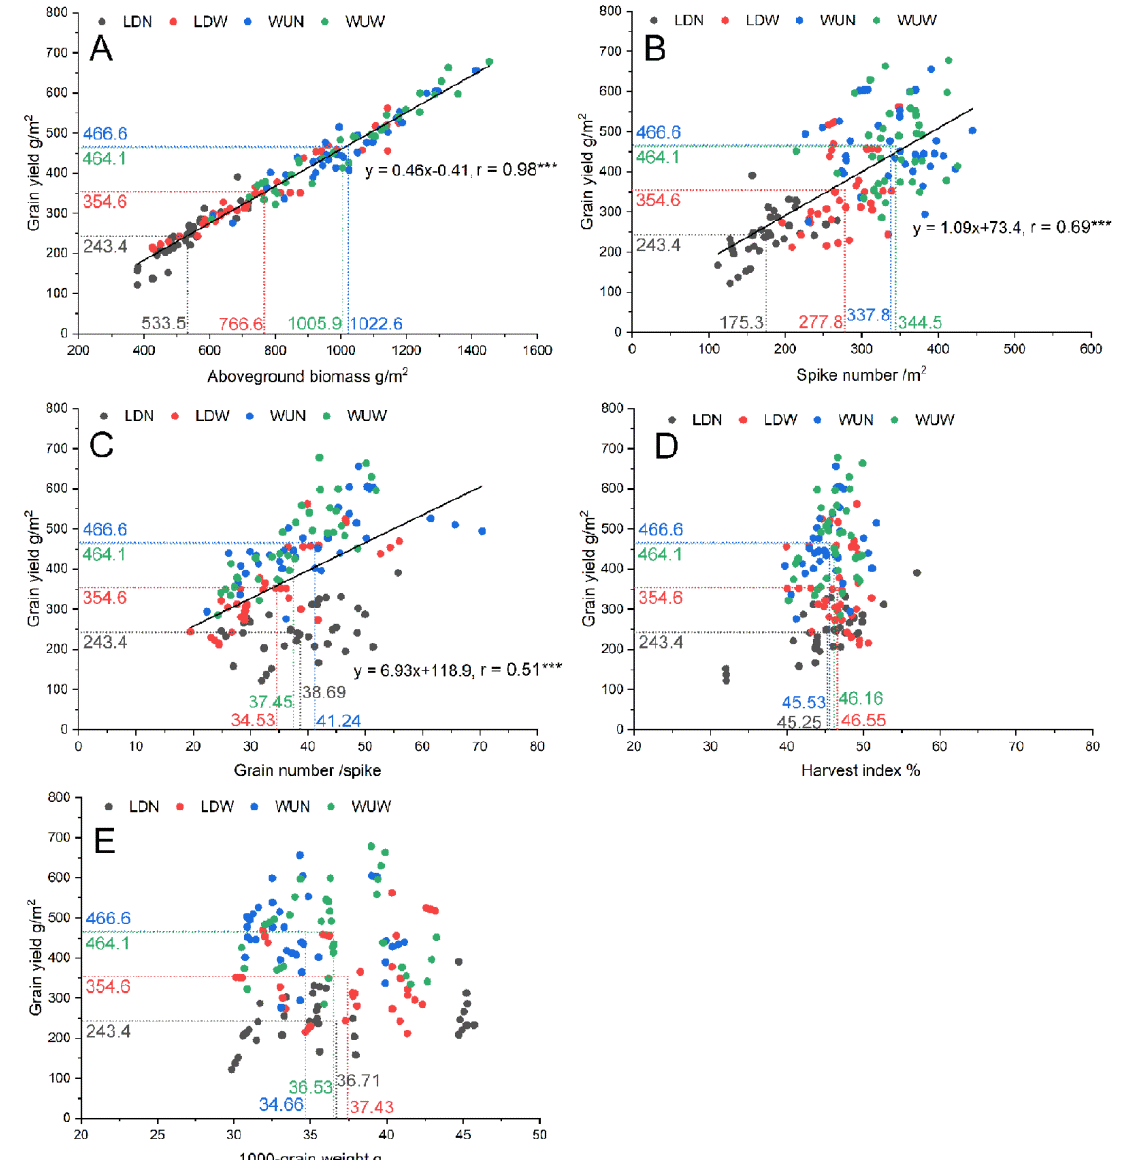
Figure 5. The relationship between the grain yield and ( A ) above-ground biomass (g m − 2 ), ( B ) spike number per square meter, ( C ) grain number per spike, ( D ) harvest index and ( E ) 1000-grain weight under four sowing patterns. *** p < 0.001.